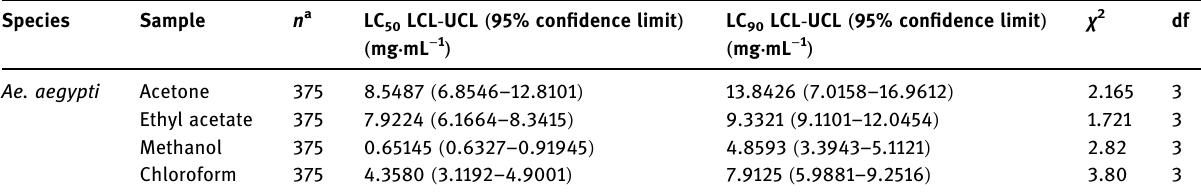
Table 4: Larvicidal activity of C. baccifera leaf extracts against fourth instar larvae of Ae. aegypti Species Sample n a